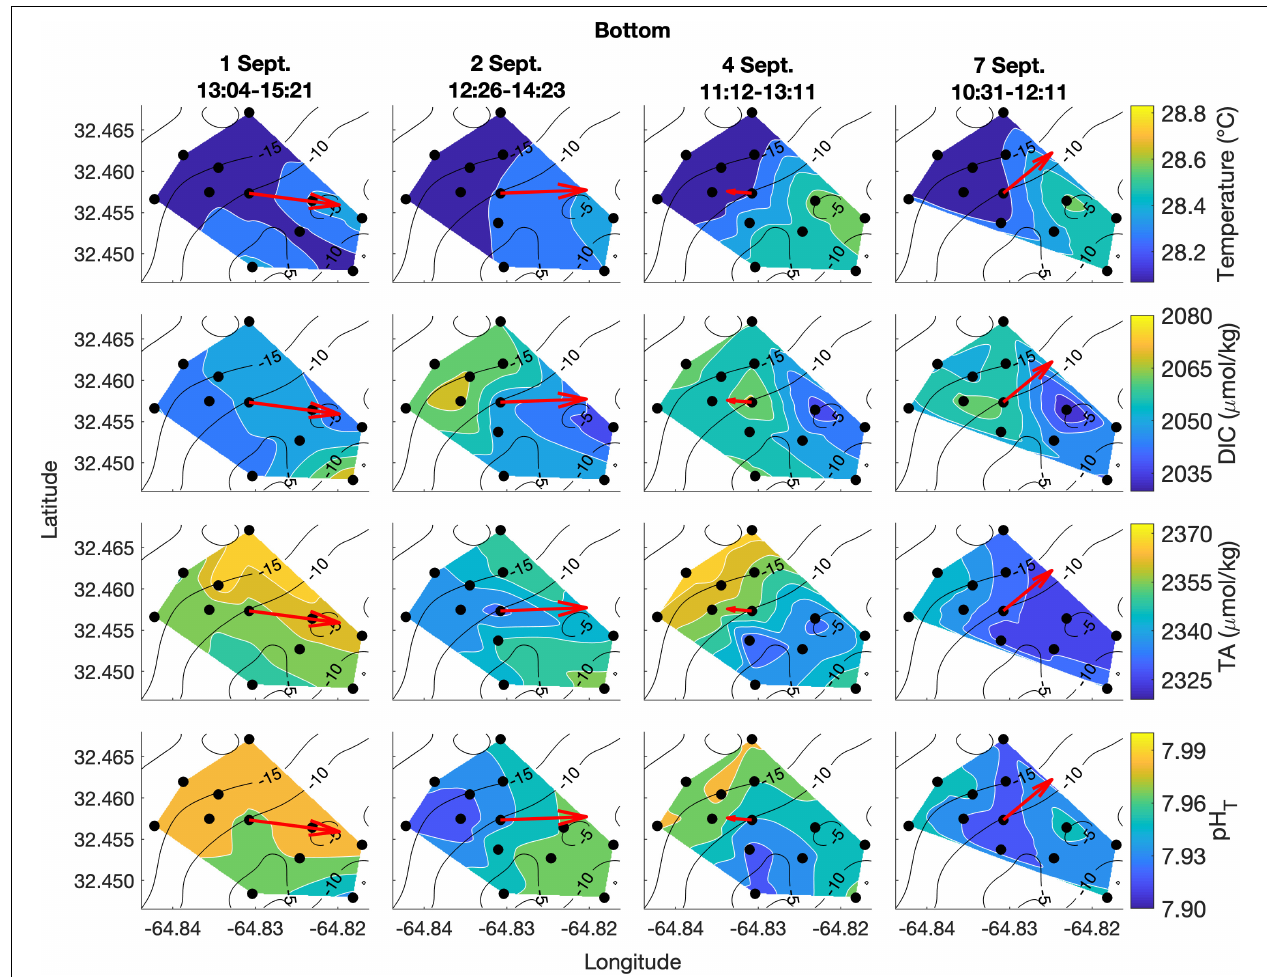
FIGURE 5 | Lateral spatiotemporal variability at the bottom in temperature, DIC, TA, and pH T (calculated from measured DIC and TA) on September 1, 2, 4, and 7. Plots also contain bathymetry contours (black) and the mean depth-averaged velocity vector averaged over the sampling period